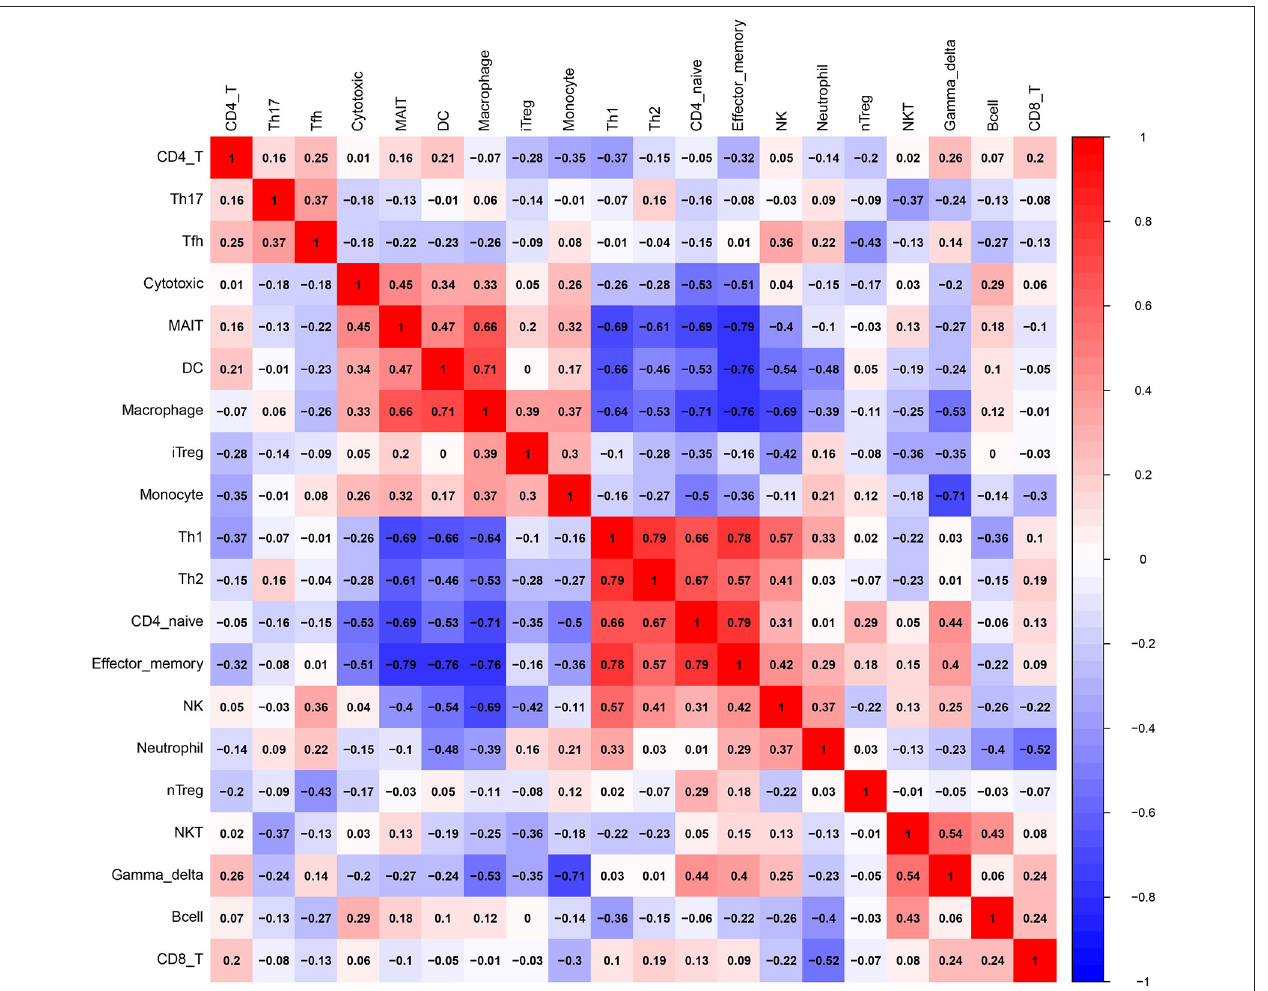
( Figure 5 ), we found some modules where specific types of immune cells had a similar expression, which suggest a synergetic role in